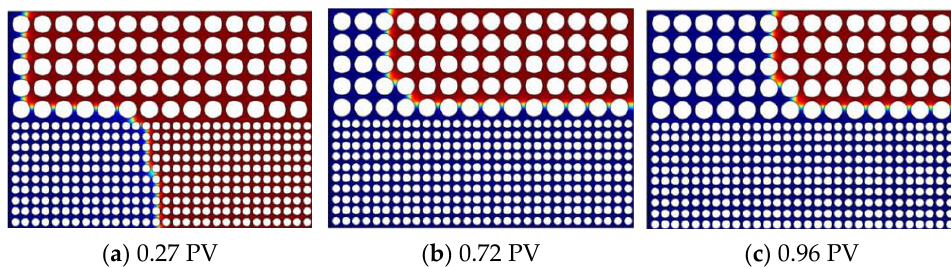
Figure 7. Distribution of oil saturation when permeability contrast is 11.11 (The polymer solution is represented in blue and the oil in red).